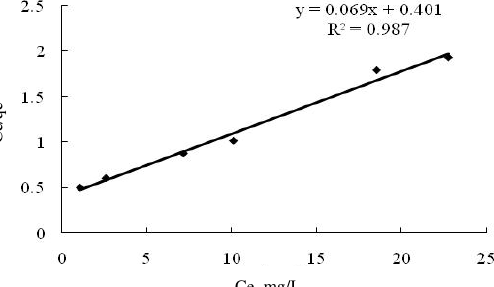
Figure 3. Adsorption isotherm obtained for Pb(II) sorption using Langmuir equation (linearized form) at 30